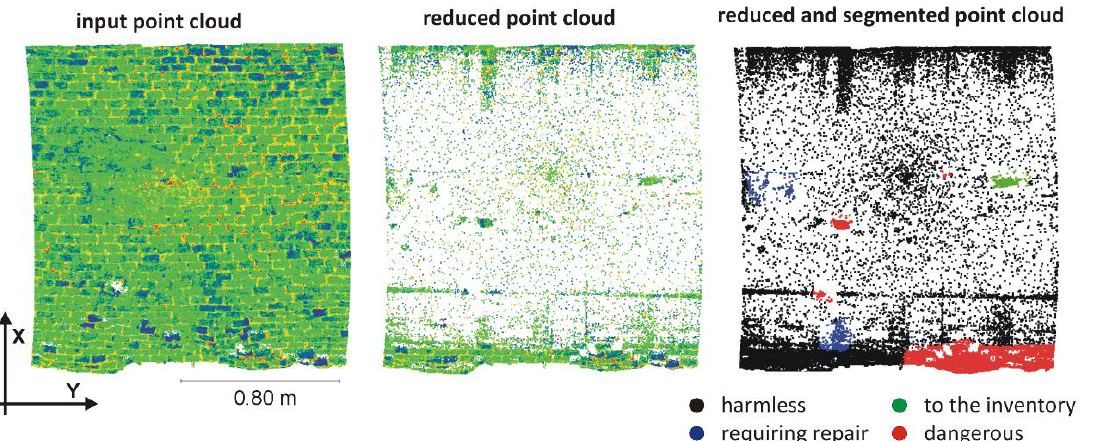
Figure 6. Detection of basement brick wall defects based on OptD segmentation in OXYZ coordinate system – object2